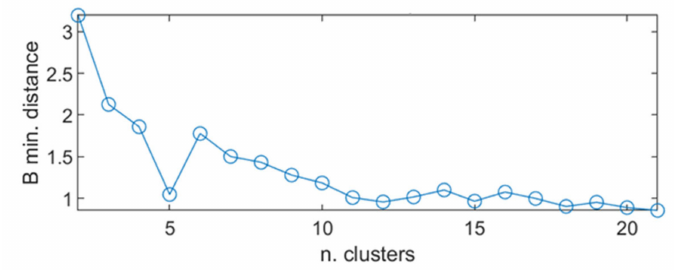
Figure 9. Minimum Bhattacharyya distance as a function of the number of clusters in the multi-frequency